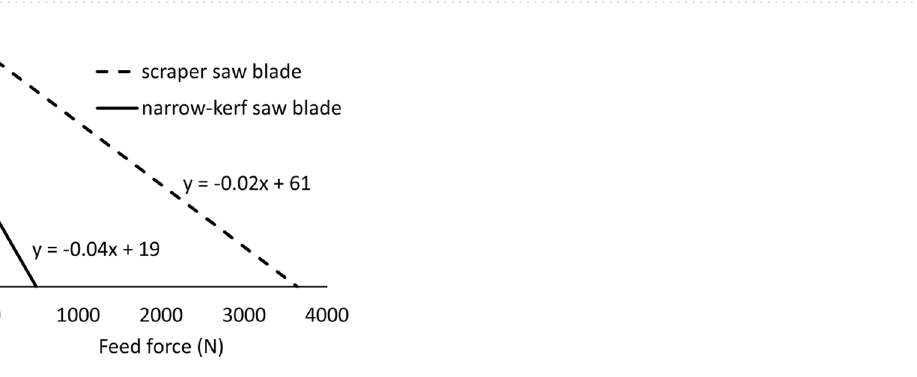
Figure 8. The operational saw blade stiffness OSBS of the narrow-kerf and the scraper saw blades expressed as a function of the feed